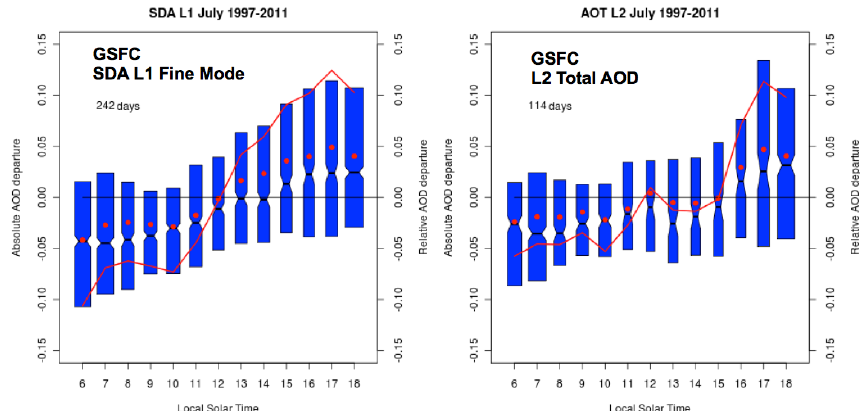
Figure 15. The GSFC site climatology for July (1997–2011) of the hourly absolute AOD departures from the daily mean values. The pinch point on the blue bars are the medians, the upper and lower limits of the blue bars represent the 75th and 25th percentiles, and the width of the bars is proportional to the number of observations in each hour. The red dots are the hourly mean absolute departures and the red line is the relative AOD departure (right side y axis). The left panel shows the analysis for the fine mode AOD without cloud screening (Level 1.0) and the right side panel shows the Level 2 Version 2 cloud screened total